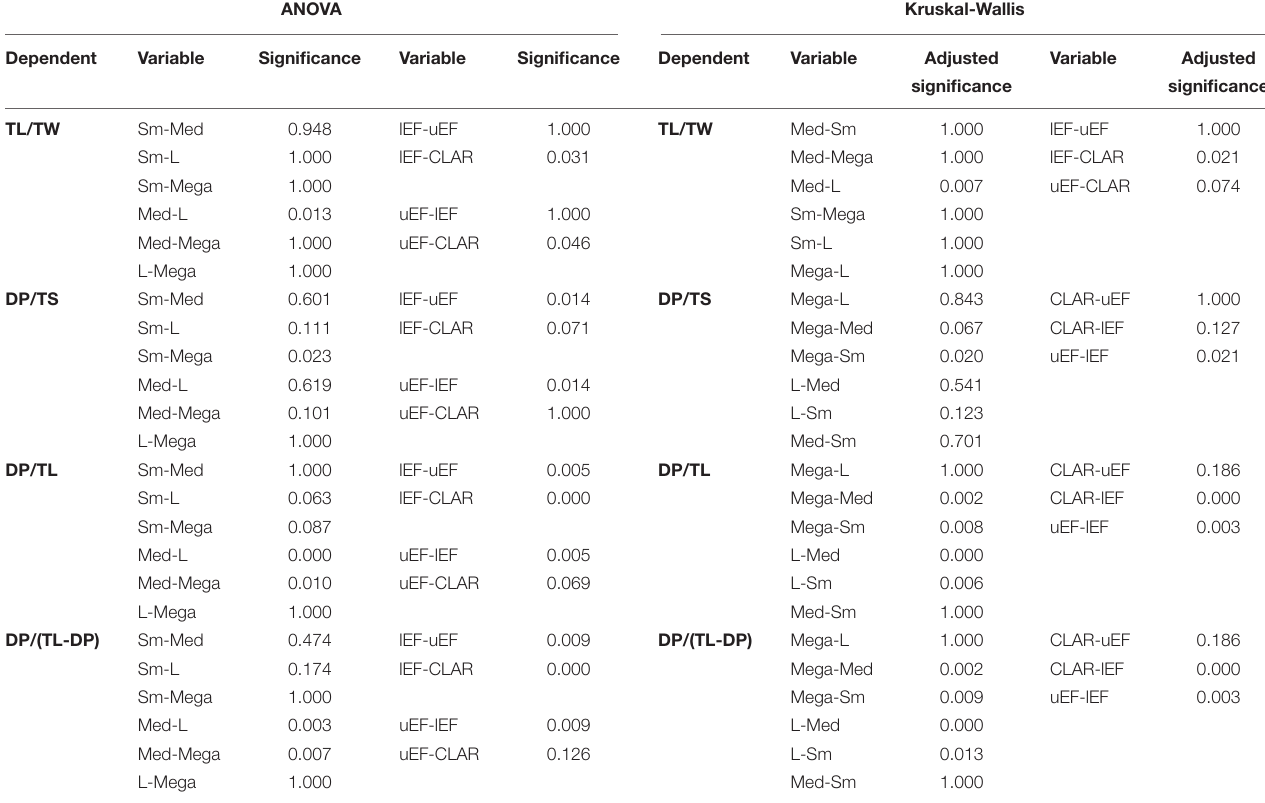
TABLE 2 | Post hoc assessment data for ANOVA and Kruskal-Wallis tests. ANOVA Kruskal-Wallis